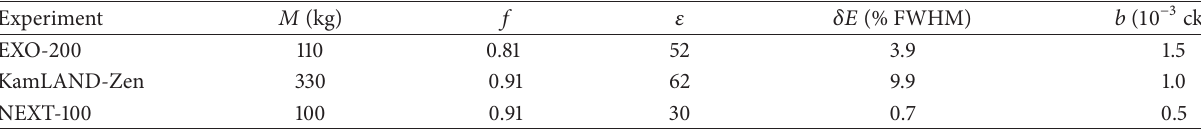
Table 1: Experimental parameters of the three xenon-based double beta decay experiments: (a) total mass of 136 Xe, 𝑀 ; (b) 𝛽𝛽 isotope enrichment fraction 𝑓 , meaning the fraction of the mass enriched in the relevant isotope for 𝛽𝛽0 ] ; (c) total efficiency, 𝜀 , defined as the percentage of the total mass actually used as source times the signal detection efficiency, which depends on the fraction of signal that escapes detection; (d) energy resolution, 𝛿𝐸 , at the 𝑄 value of 136 Xe; and (e) background rate, 𝑏 , in the region of interest around 𝑄 𝛽𝛽 expressed in counts/(keV ⋅ kg ⋅ y) (shortened as ckky) [28].